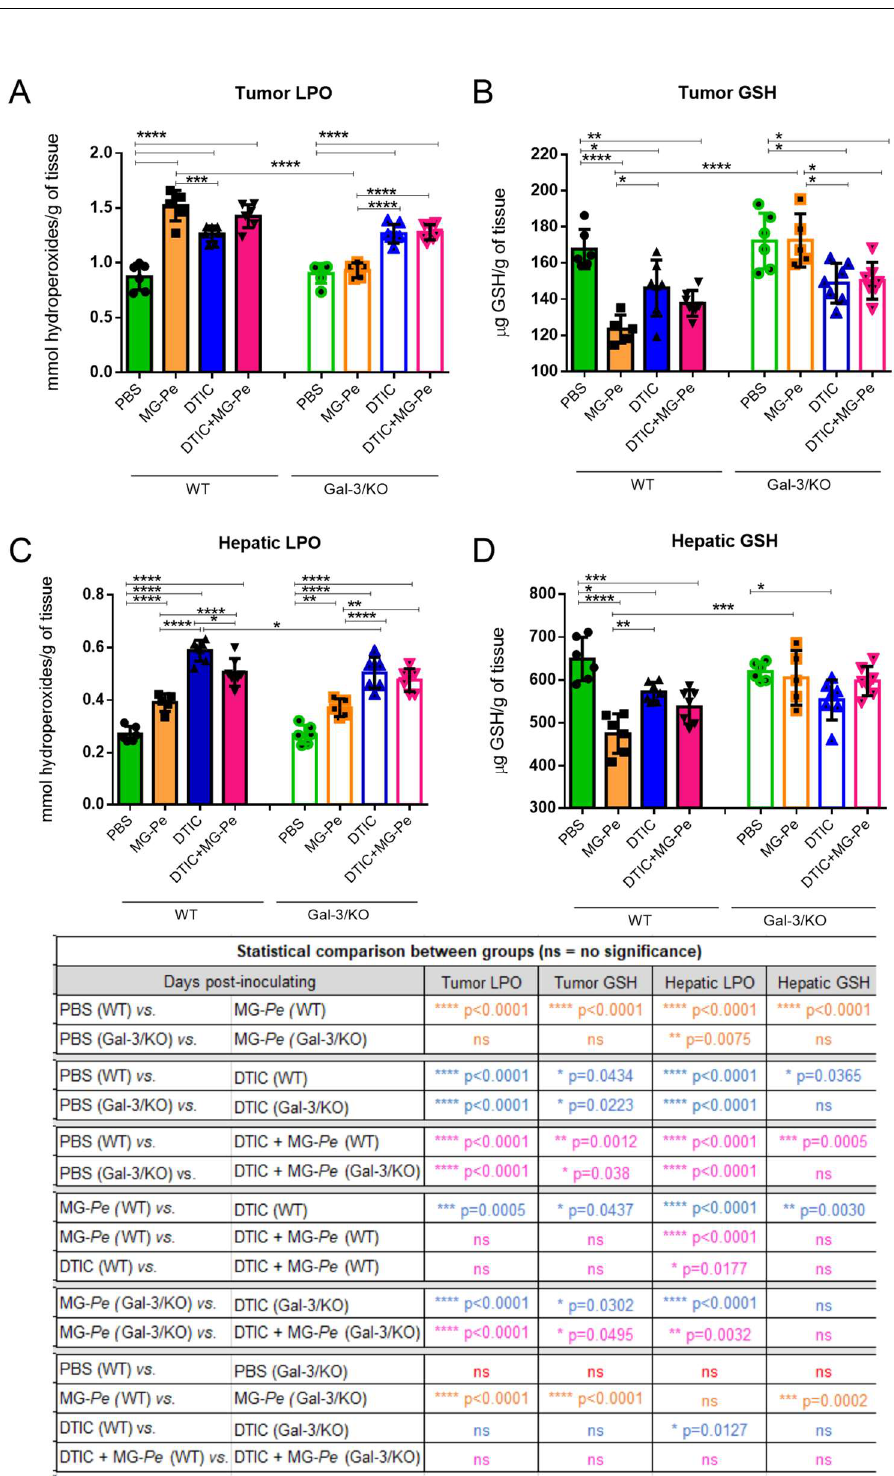
Figure 5. Tumor Effects of MG- Pe in oxidative stress. Tumor ( A , B ) and hepatic ( C , D ) levels of reduced glutathione and lipoperoxidation from wild mice—WT (C57BL/6) or Galectin-3 knockout mice (C57BL/6 Gal-3/KO). Animals were treated with PBS (control, n = 6), partially methylated mannogalactan (MG- Pe 50 mg/kg, n = 6), Dacarbazine (DTIC 40 mg/kg, n = 7) or with Dacarbazine+MG- Pe (DTIC+MG-Pe, n = 7). Statistical analysis was performed by one-way ANOVA, followed by Dunnet’s post-test. Values are presented as mean ± SEM; * p ≤ 0.05, ** p ≤ 0.01, *** p ≤ 0.001, **** p ≤ 0.0001. The effect of MG- Pe on the redox regulation is probably one of its antitumor actions Adaptation to oxidative stress and drug resistance is a common process in cancer. but not the only one. The redox system in the tumor works different to normal cells, since Tumor cells increase ROS due to altered metabolic demand, thus favoring a redox